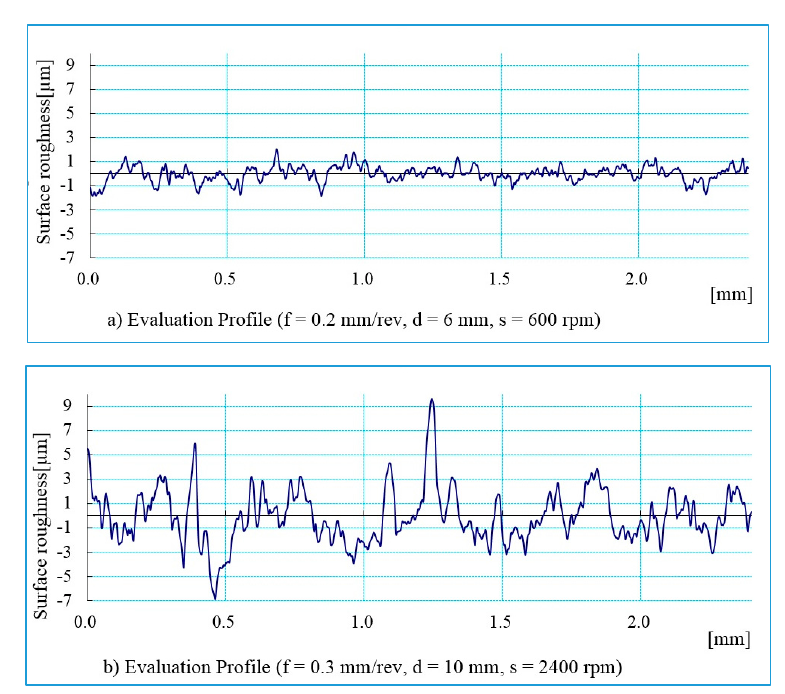
Figure 8. Surface roughness profile for drilled holes with different cutting conditions: ( a ) f = 0.2 mm/rev, d = 6 mm, s = 600 rpm; and ( b ) f = 0.3 mm/rev, d = 10 mm, s = 2400 rpm.